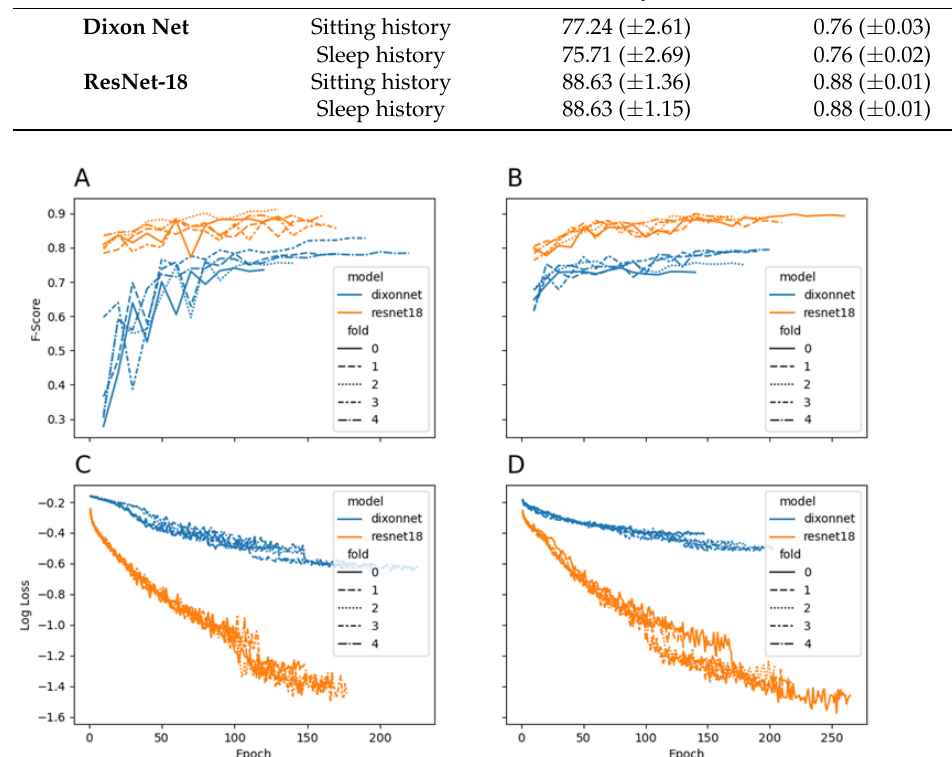
Figure 4. The average model performance across each fold for sitting and sleep history classification. Panel ( A ) evaluation accuracy (F-score) for sitting history; Panel ( B ) evaluation accuracy (F-score) for sleep history; Panel ( C ) natural log of the training loss for sitting history; Panel ( D ) natural log of the training loss for sleep history.